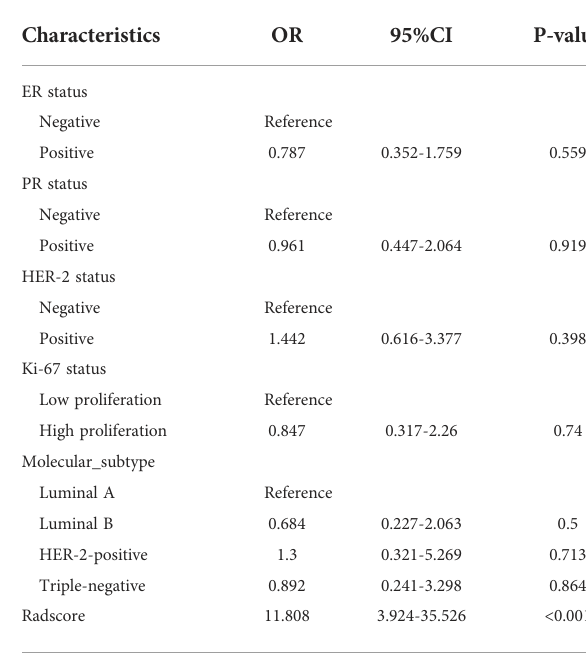
TABLE 5 Univariate logistic analysis for the risk factors of